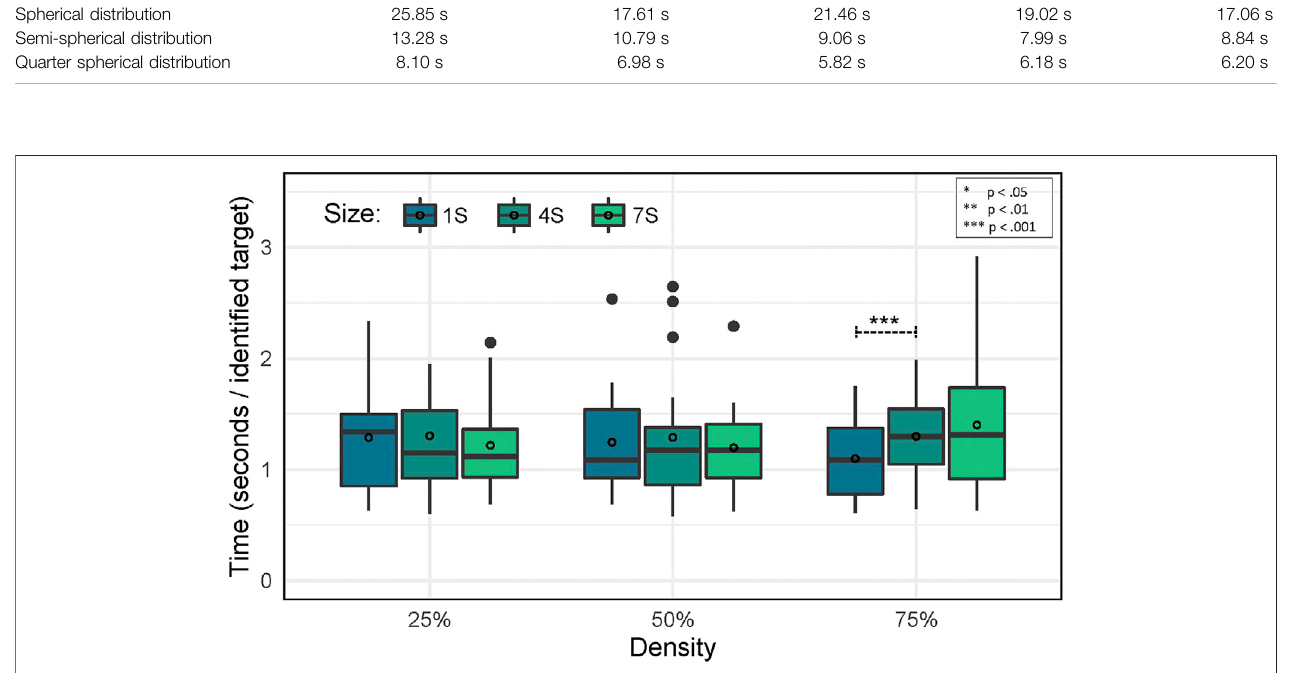
FIGURE5| SearchtimeforeachlevelofGRF Size and Density .When Density is75%,GRFswithSize1S( M (cid:2) 1 . 236 ± 0 . 692)performsigni fi cantlyfasterthanSize 2S ( M (cid:2) 1 . 426 ± 0 . 690). The circle outlines represent the mean values for each condition.